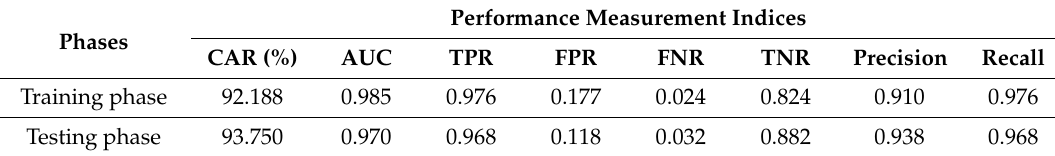
Figure 10. Optimization process of the proposed hybridization of FA and LM. Table 3. Prediction performance of the FA-LM ANN model.